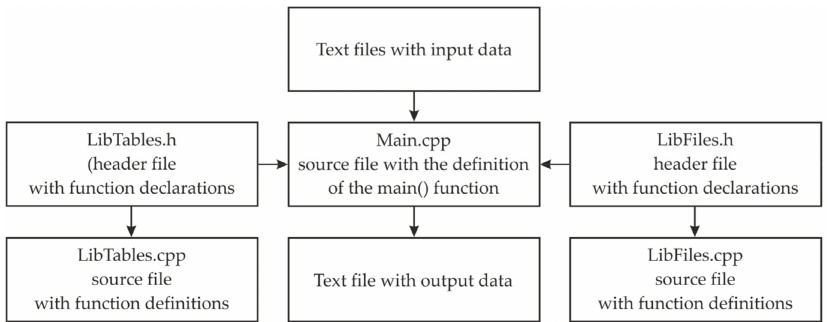
Figure 8. Block diagram of the developed computer program.